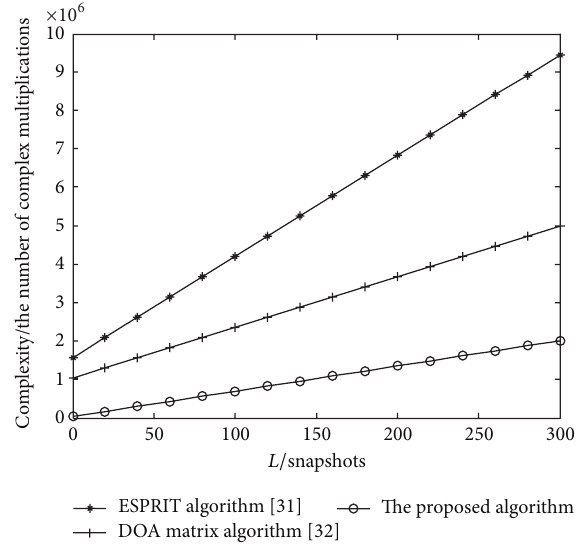
Figure 1: Complexity comparison with 𝑀 = 9 , 𝑁 = 9 , 𝐾 = 3 , and different 𝐿